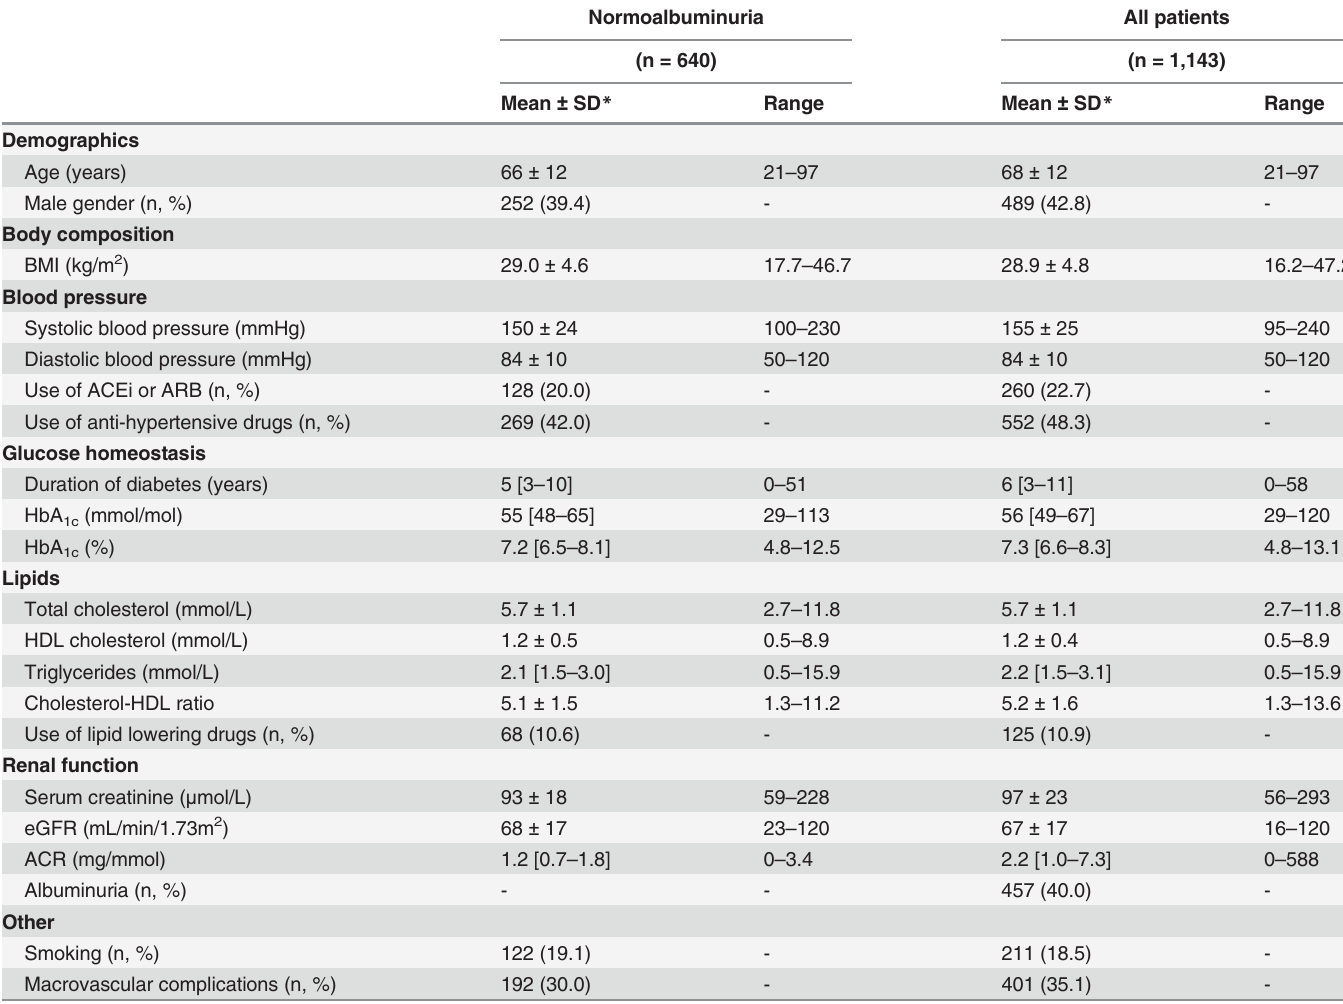
Table 1. Baseline patient characteristics of the ZODIAC study population. Normoalbuminuria All